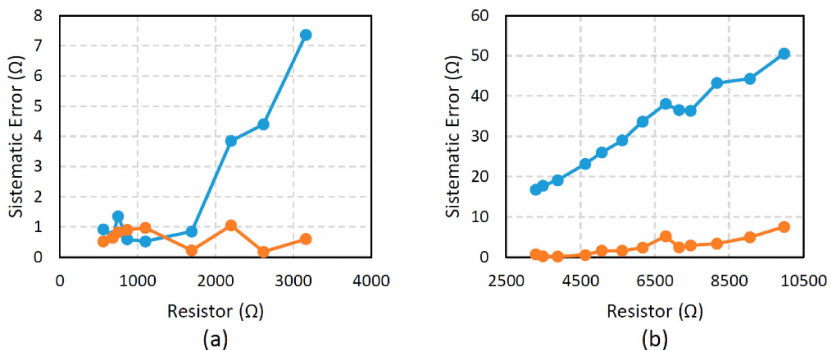
Figure 8. Systematic error in the two ranges of resistors used in Experiments 3 and 4. The results obtained by Equation (22) are shown in blue, and the results obtained by Equation (44) in red; ( a ) results from Experiment 3; ( b ) results from Experiment